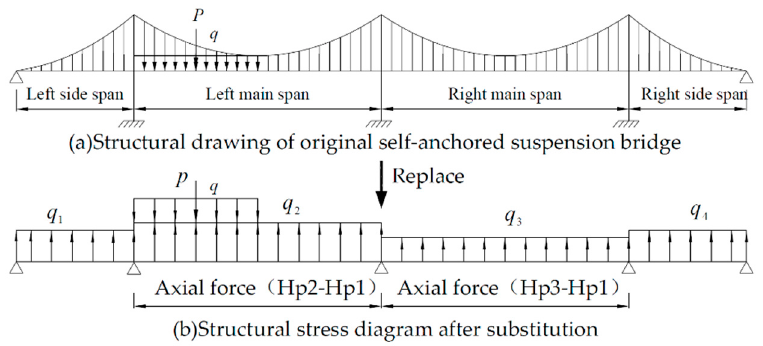
Figure 2. Substitutional beam under live load. q 1 , q 2 , q 3 and q 4 = the uniform tension of suspension cable.